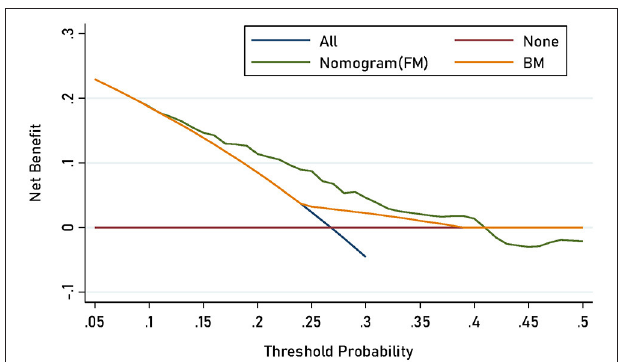
FIGURE 3 | The logistic calibration curve of the prediction nomograms of risk factors for SA in MDD patients. FIGURE 4 | DCA for the prediction nomograms of risk factors for SA in